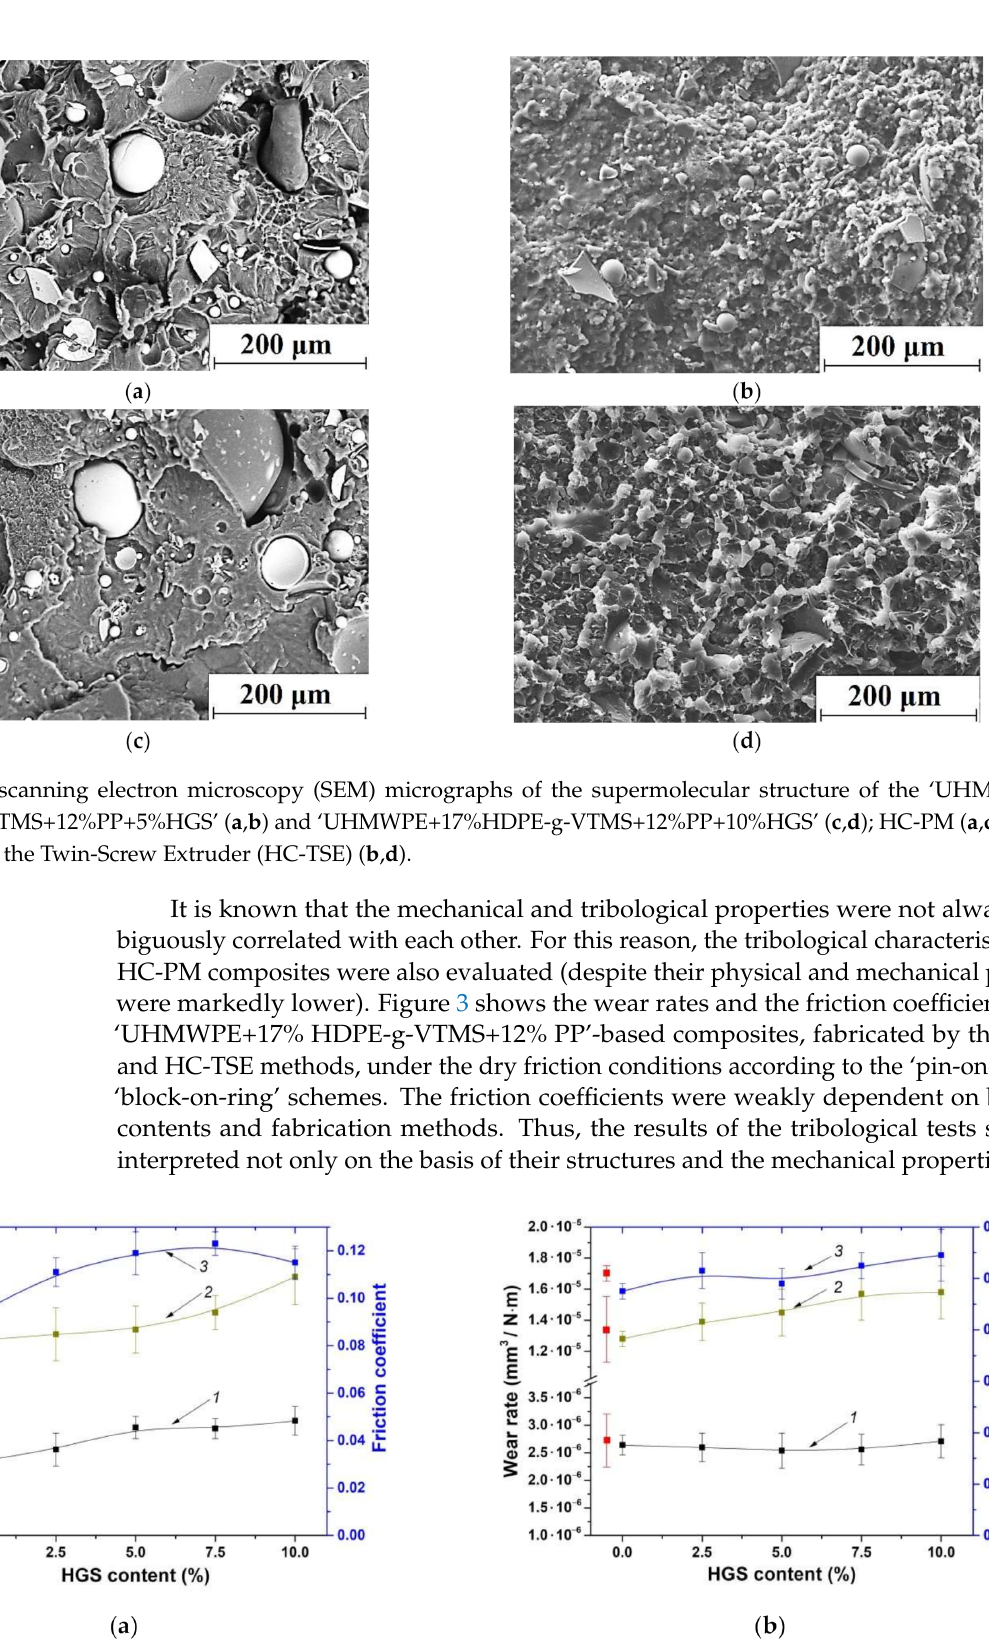
Figure 3. Wear rates according to the ‘pin-on-disk’ (curve 1, 5 N · 0.3 m/s) and ‘block-on-ring’ (curve 2, 60 N · 0.3 m/s) schemes as well as the average friction coefficients (curve 3) versus filler weight fraction: HC-PM ( a ), HC-TSE ( b